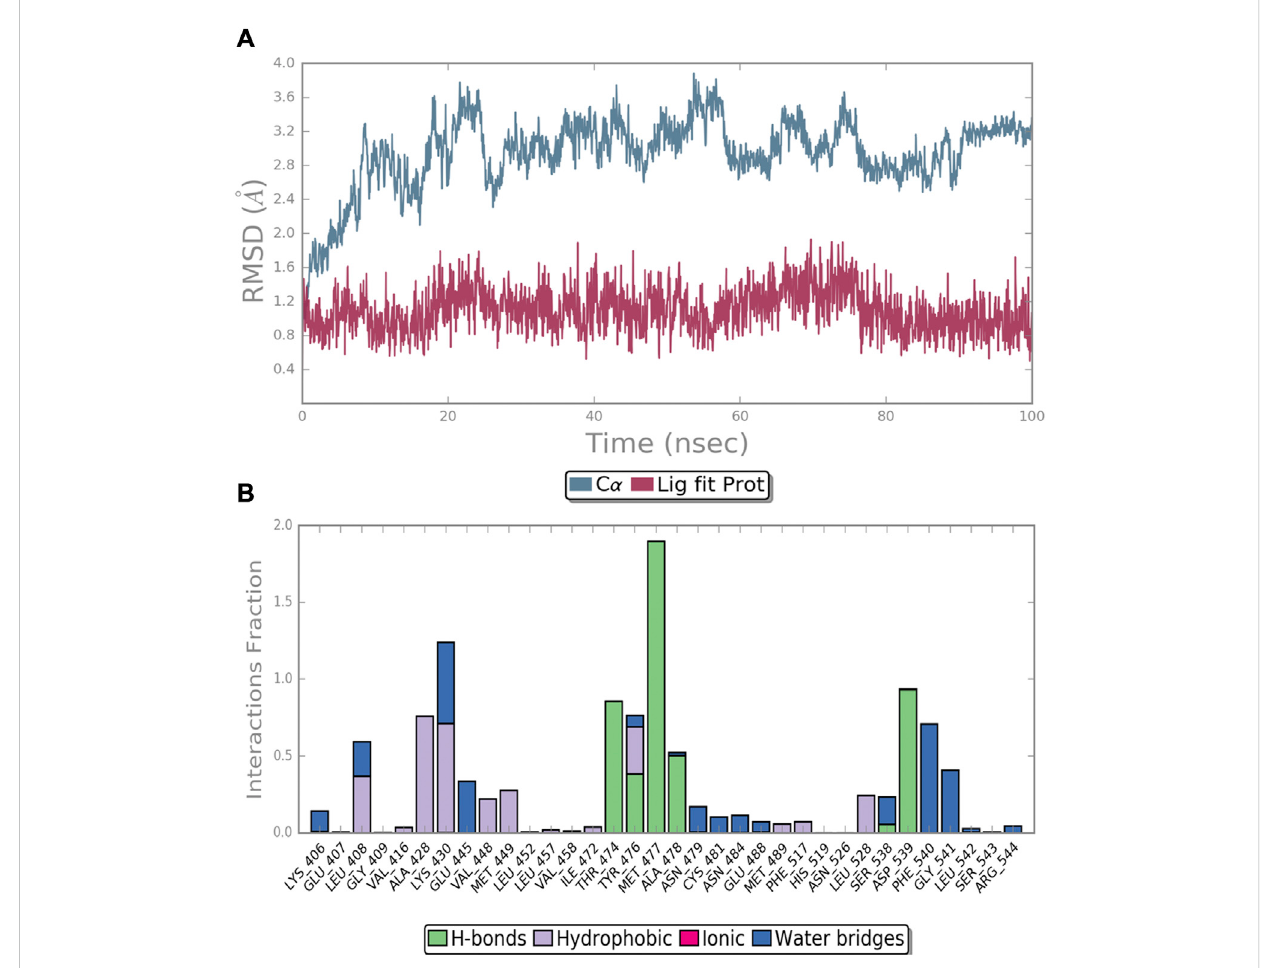
FIGURE 5 MD simulation of the BTK protein in complex with compound 4 : (A) RMSD of protein and ligand; (B) protein − ligand contacts during the simulation.